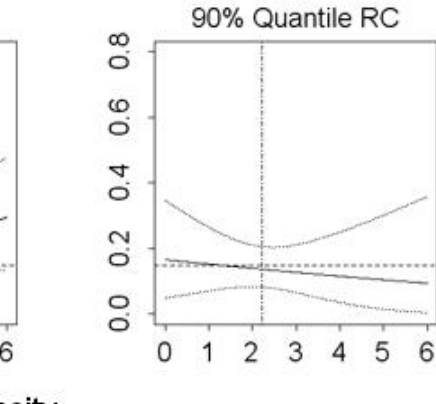
Fig. 3 . Predicted duck nesting success and 95% CIs (dotted lines) in the Aspen Parkland of Alberta, Canada, in relation to nest-site vegetation density and field residual cover (RC), based on the most parsimonious nesting success model DSR (nest-site vegetation density*residual cover; n = 633 nest-fate intervals). Nest-site vegetation density was quantified as the mean of four visual obstruction measurements taken at each nest in each of the cardinal directions. Nest-site vegetation density and RC were not correlated (Pearson’s product-moment correlation, r < 0.01, P = 0.83). The horizontal dashed line represents the hypothesized threshold level of nesting success (0.15) believed necessary to maintain a mallard population (Cowardin et al. 1985, Klett et al. 1988). The vertical line represents the average nest-site vegetation density (2.2 dm) during the